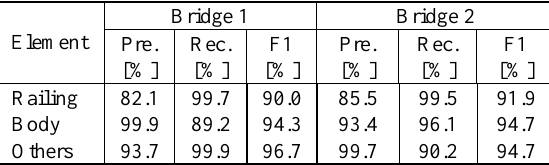
Figure 12. The noise removal for: a: bridge 1; and b: bridge 2.